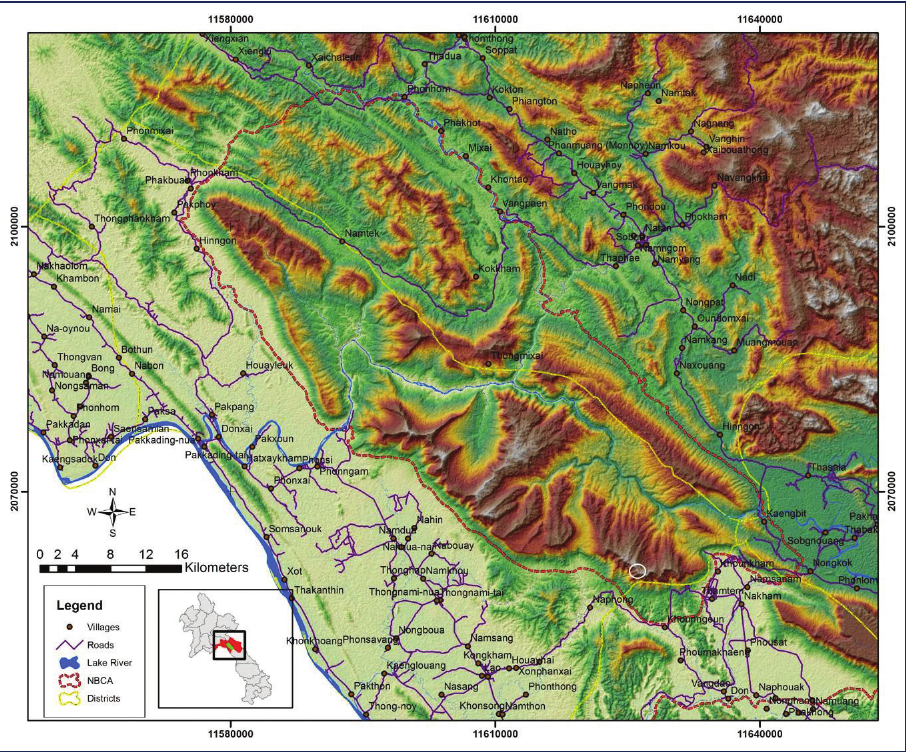
Figure 1. Locality of Nam Kading National Protected Area. White circle indicates where we found Strobilanthes namkadingensis Soulad. &